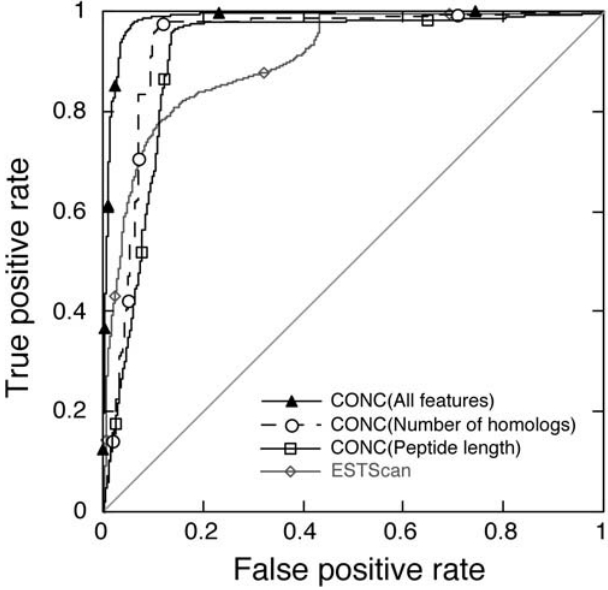
Figure 1. The ROC Curves for CONC A ROC curve plots the true positive rate (i.e., sensitivity) against the false positive rate (i.e., 1 (cid:1) specificity). Shown are the ROC curves for CONC using all features, two of the top single features, and ESTScan. The diagonal line indicates random prediction.